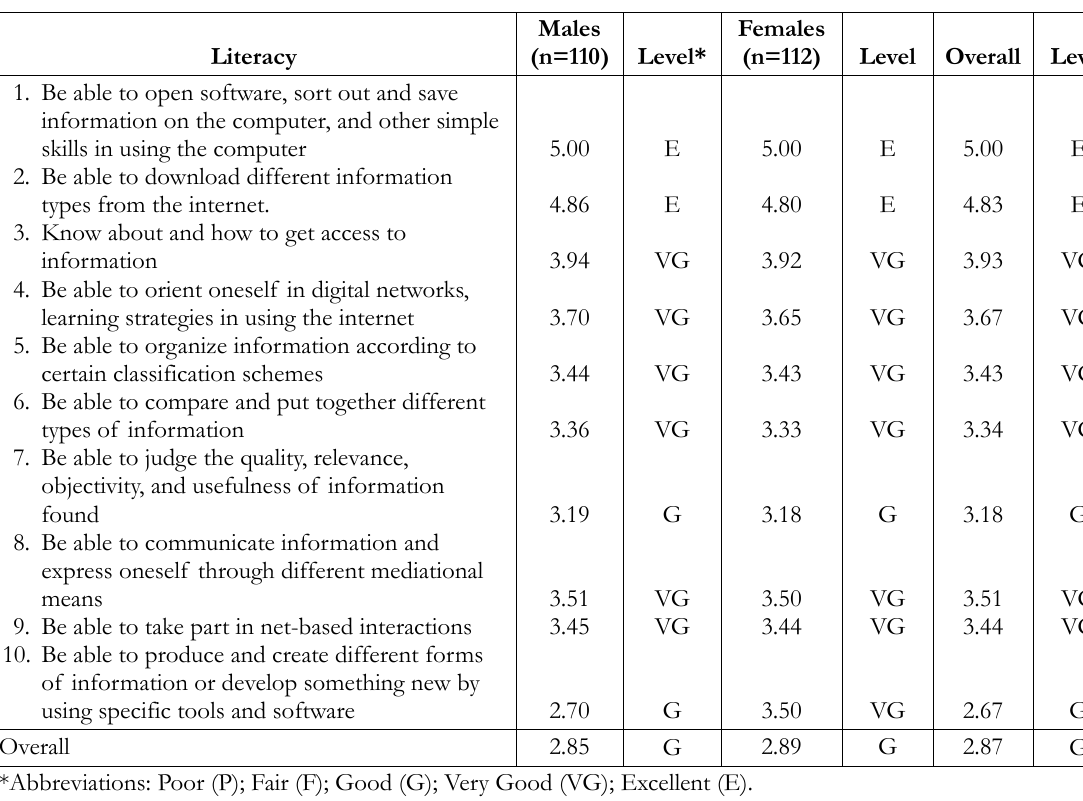
Table 8. Self-perceived media